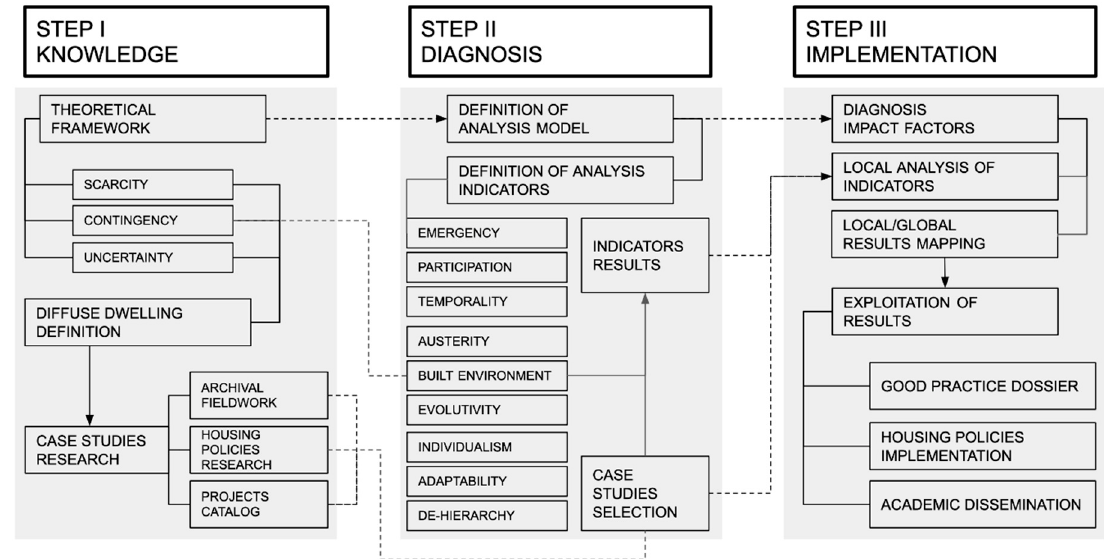
Figure 7. Research flowchart. Author’s own construction, 2020.